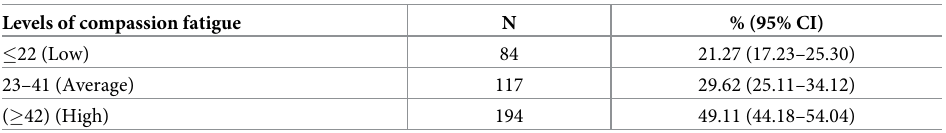
Table 2. Level of compassion